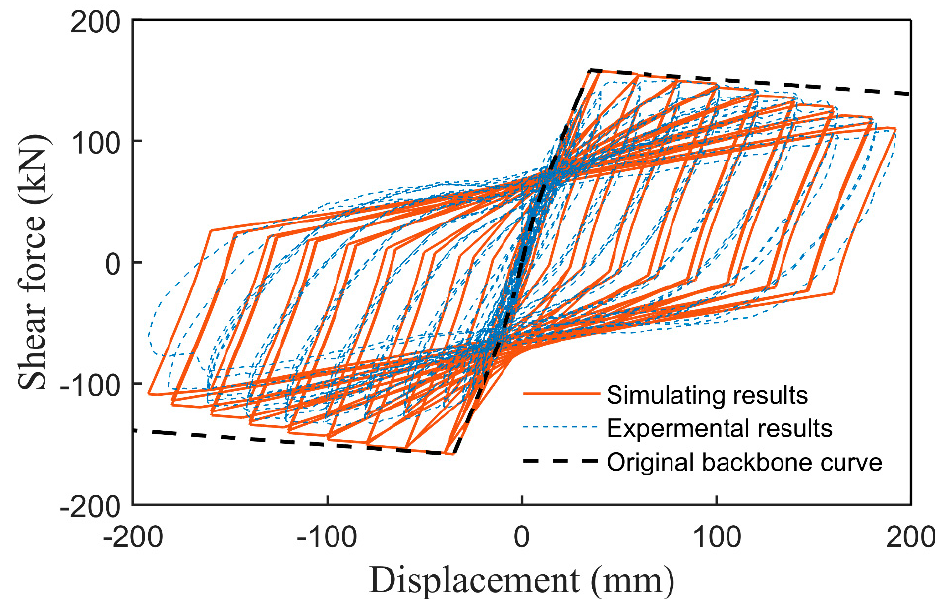
Figure 6. Validation with quasi − static test results.